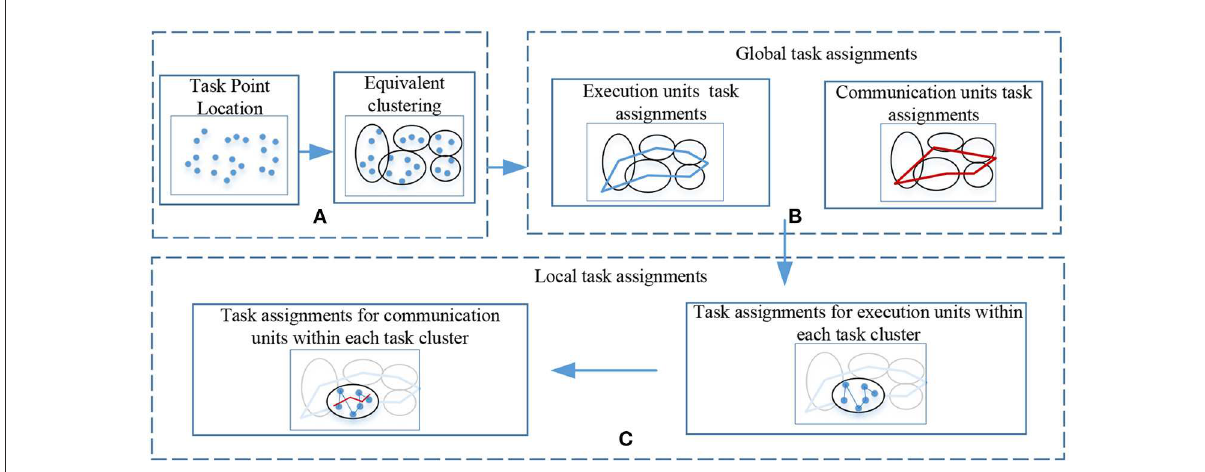
FIGURE1 Flowchart for solving cluster collaborative task assignment. (A) Perform equivalent clustering on all task nodes, and generate several task cluster units after clustering. (B) Perform global task assignment of execution units and communication units according to the equivalent clustering results. (C) According to The result of the global task assignment is to assign tasks to the communication unit and the execution unit within the task cluster.